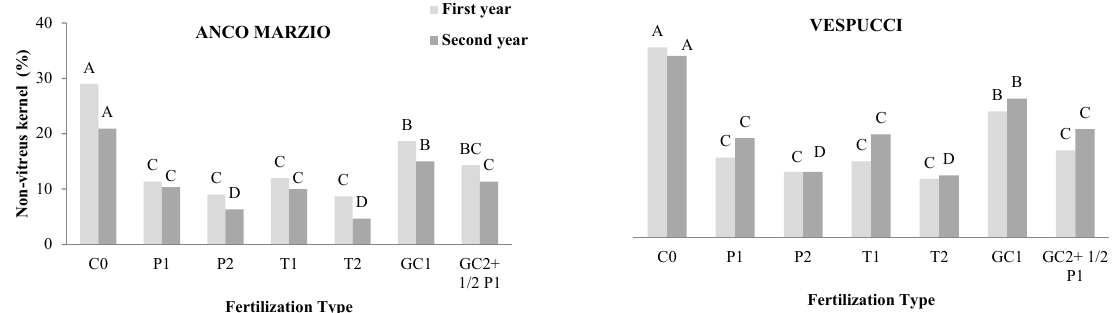
Figure 9. Mean values of non-vitreous kernel percentage in two durum wheat cultivars (Anco Marzio and Vespucci) grown under different fertilization regime during the first and second year. For each effect considered, the values followed by the same letter are not significantly different, according to the SNK test at p = 0.01.